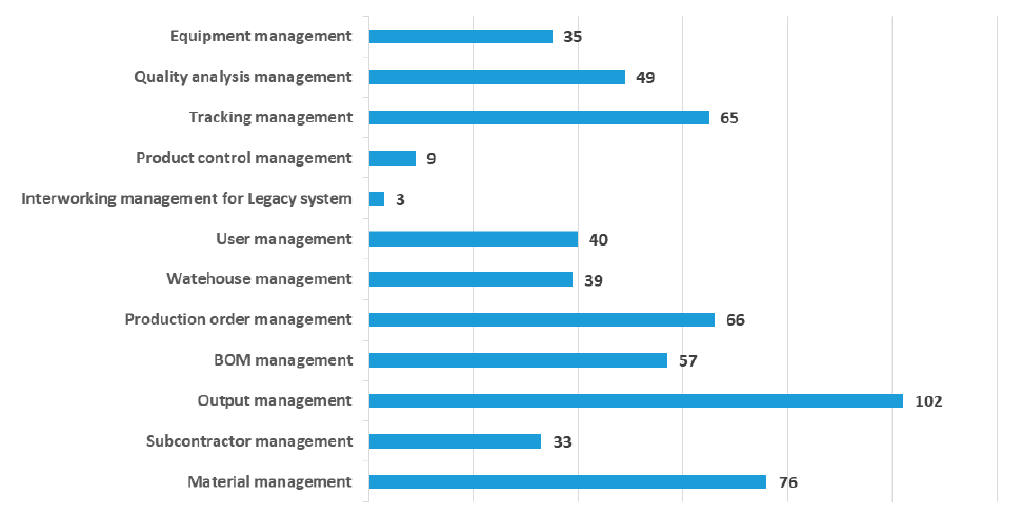
Figure 7. MES (Manufacturing Execution System) module.